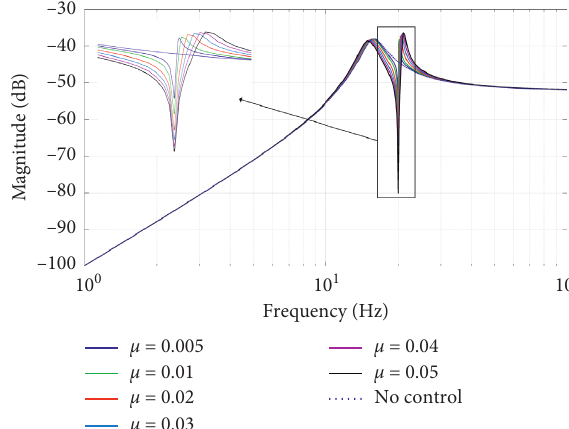
Figure 4: Logarithmic amplitude-frequency characteristic curves of the structure with and without the FATMD (varying μ ).